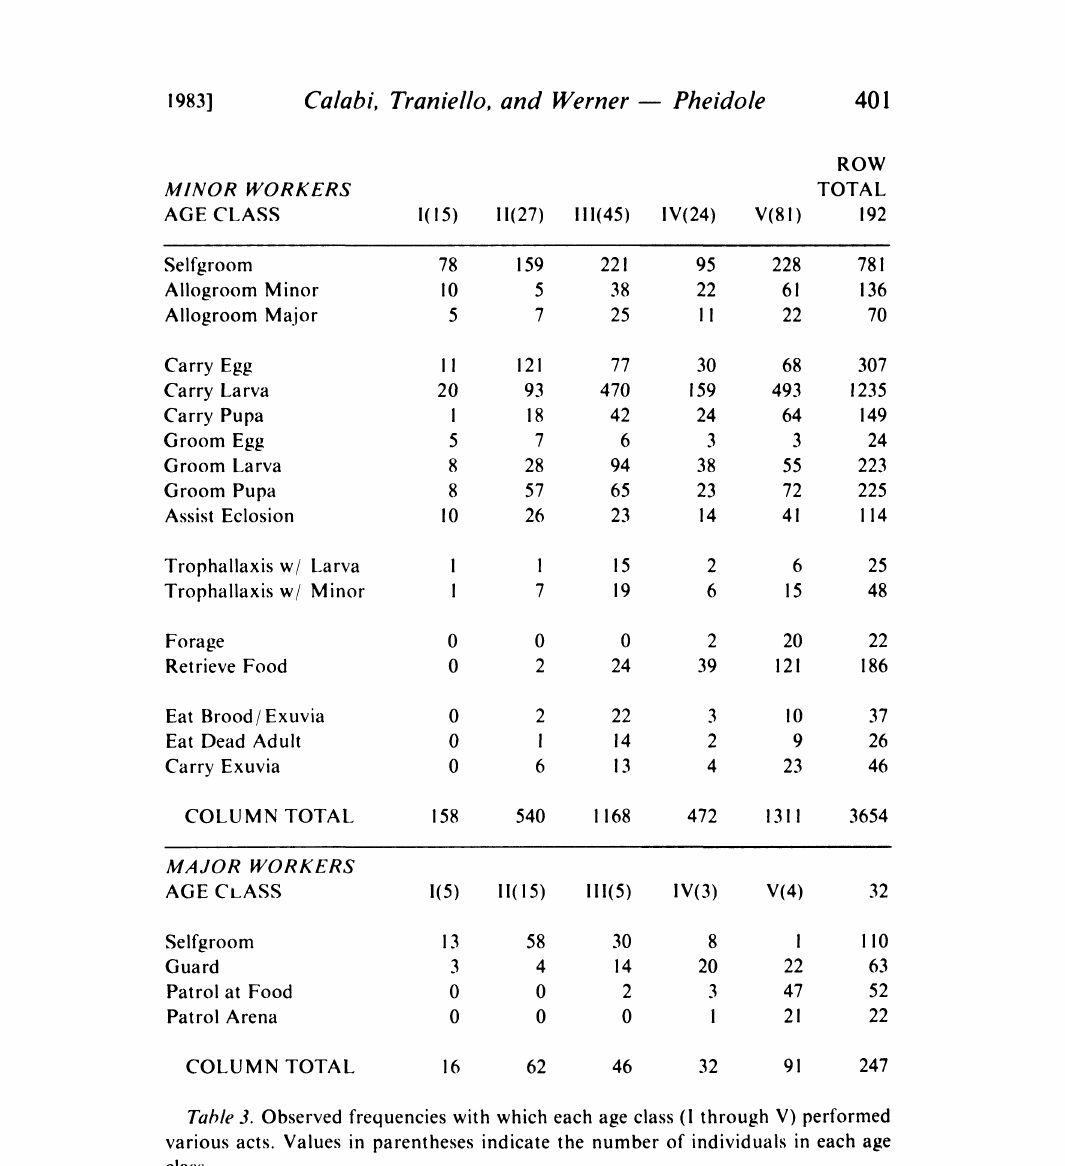
Table 3. Observed frequencies with which each age class (! through V) performed various acts. Values in parentheses indicate the number of individuals in each age